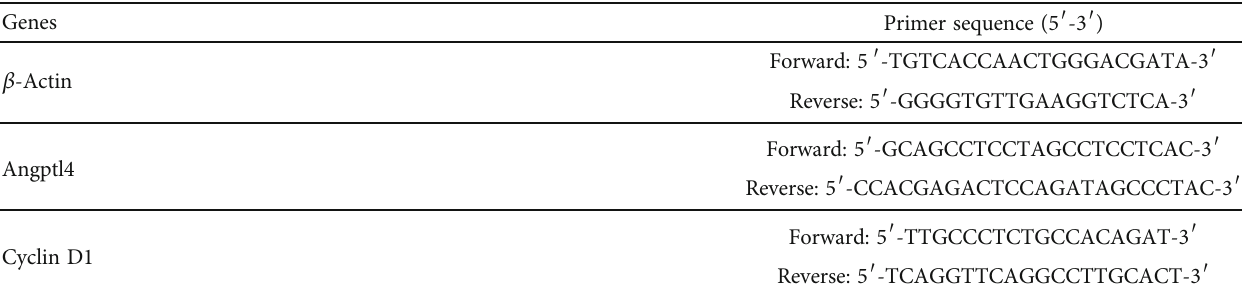
Table 1: Primer sequences for the ampli fi cation of target genes.